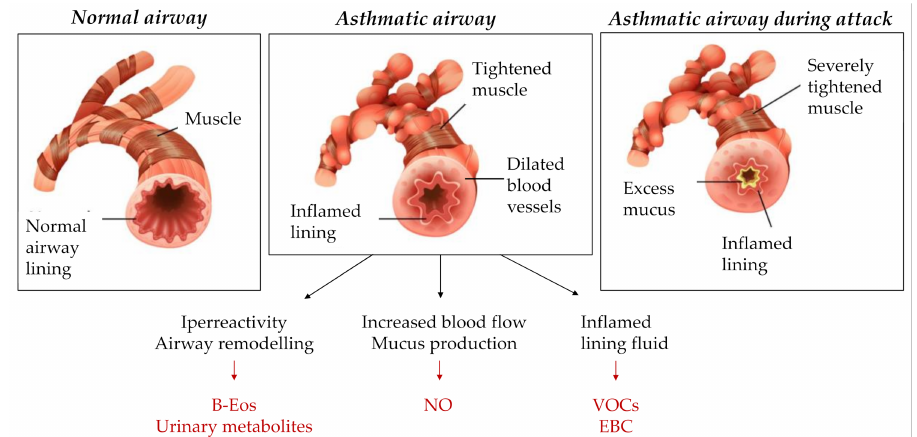
Figure 2. Biomarkers as indicators of pathological modification in asthmatic airways. Abbreviations: B-Eos = blood eosinophils; NO = nitric oxide; VOCs = volatile organic compounds; EBC = exhaled breath condensate. Image in collaboration with: